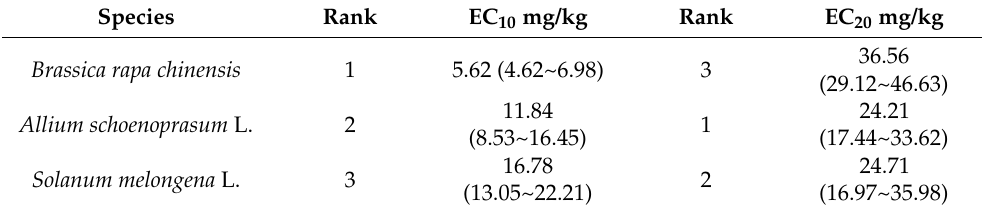
Figure 2. The inhibition rate of Cr(III) on root elongation of 11 plants: ( a ) leafy vegetables; ( b ) solana- ceous vegetables; ( c ) wheat, gourd vegetable and stem vegetable. Bars represent standard error ( n = 3). Table 4. Inhibition effects of Cr(III) on root elongation of 11 terrestrial